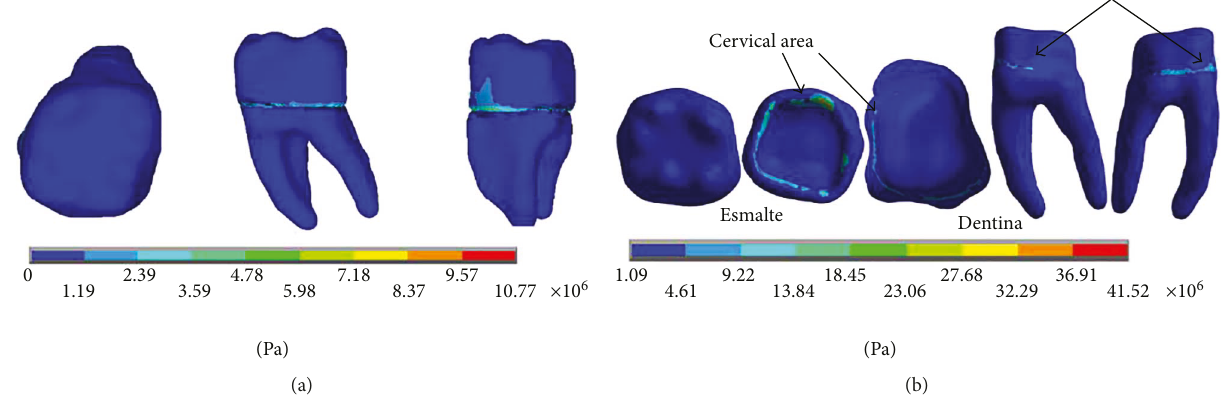
Figure 9: von Mises stress. (a) Contact. (b) Noncontact.